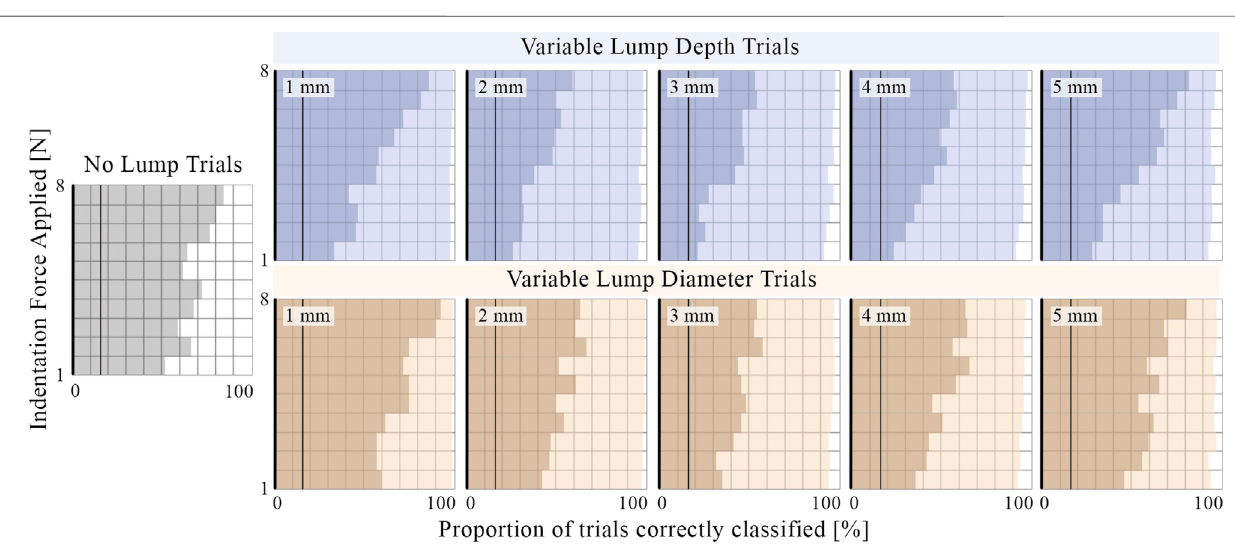
random guessing across the six classes. Results are averaged across readings from all baseline internal pressures (0 − 200 mbar ) and shown across a range of indentation forces up to 8 N . The presence of smaller diameter lumps embedded at shallower depths are more easily identi fi ed. The depth and diameter classi fi cation accuracy of identi fi ed lumps is low with light indentation force but improves as greater indentation force is applied.